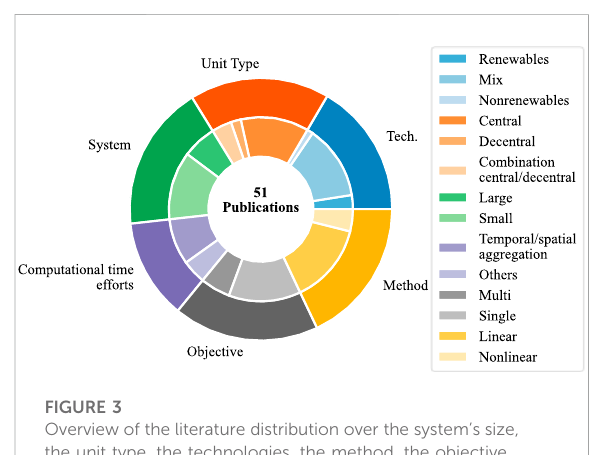
FIGURE 3 Overview of the literature distribution over the system ’ s size, the unit type, the technologies, the method, the objective function, and efforts for lowering computational